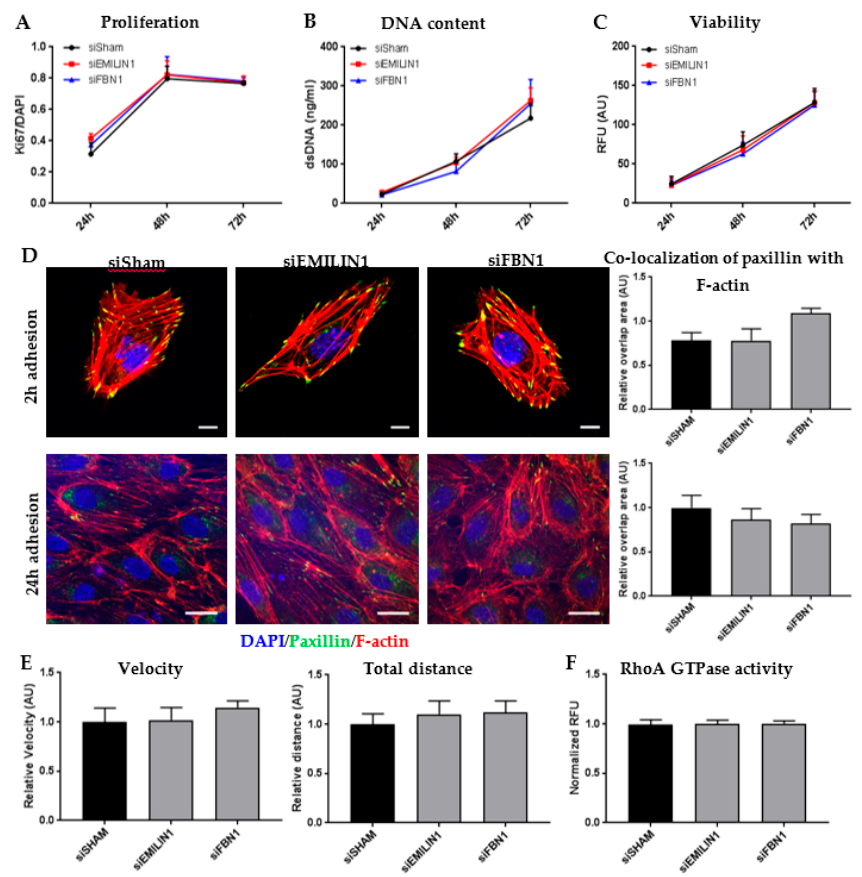
Figure 5. ( A ) Ki67-positive cells/DAPI ratio was used as measure for human umbilical vein endothelial cell (HUVEC) proliferation after 24, 48, and 72 h of culturing on siRNA-treated extracellular matrix (ECM). Shown are mean ± SEM, N = 20 fluorescent images per assay, N = 3 assays. ( B ) DNA content measurements with the PicoGreen assay was used as measure for HUVEC proliferation after 24, 48, and 72 h of culturing on siRNA-treated ECM. Data are shown as mean ± SEM, N = 3. ( C ) HUVEC viability was measured with PrestoBlue after 24, 48, and 72 h of culturing on siRNA-treated ECM. Data are shown as mean ± SEM, N = 3. ( D ) Representative z-stacks of HUVECs cultured on siRNA-treated ECM for 2 h (not confluent) to show initial binding to the ECM and 24 h (confluent) to show paxillin and F-actin changes. Scale bar represents 20 µm. Co-localization of paxillin and F-actin were quantified in both assays. Data are shown as mean ± SEM, N = 10 fluorescent images per assay, N = 4 assays. ( E ) Live cell migration assay results showing the velocity and total distance of HUVECs cultured on siRNA-treated ECM. Data are shown as mean ± SEM, N ≈ 10 HUVECs per image, N = 10 images per assay, N = 6 assays. ( F ) RhoA activation measurements using the G-LISA RhoA GTPase activity assay in HUVECs cultured 24 h on siRNA-treated ECM. Data are shown as mean ± SEM, N = 4.